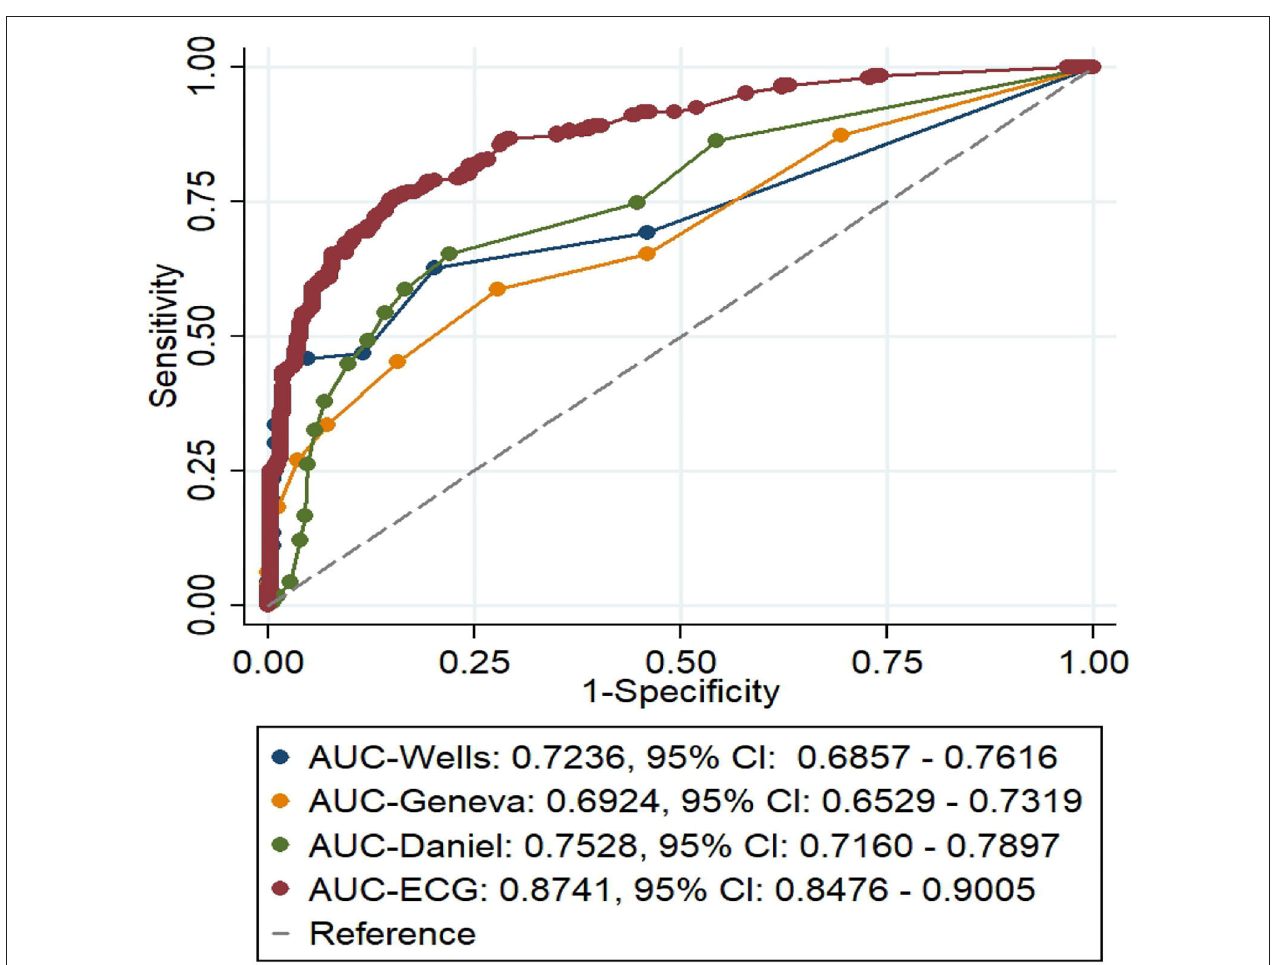
TABLE 5 | The comparison of the sensitivity, specificity, accuracy, and positive and negative predictive values of the four models. Indicators Wells simplified Geneva revised, simplified Daniel SPHH-ECG Sensitivity 13.46% 6.12% 25.99% 79.08% Specificity 99.40% 100.00% 95.17% 79.76% Positive predictive value 95.65% 100.00% 84.16% 79.32% Negative predictive value 53.76% Accuracy